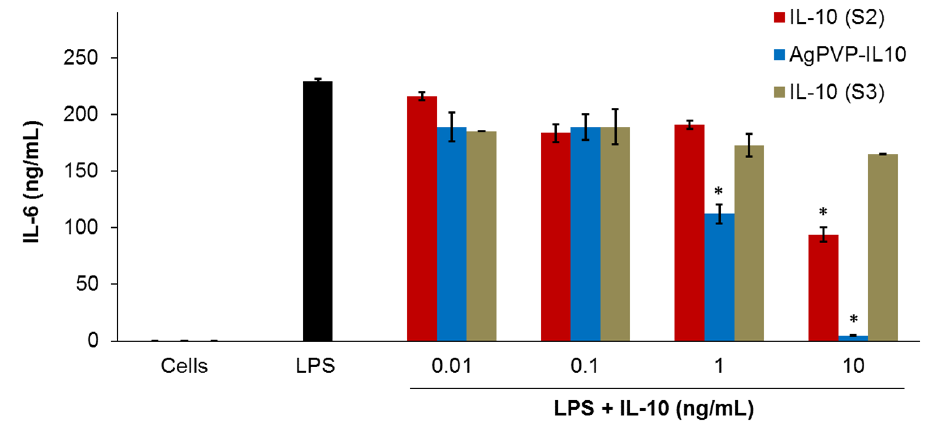
Figure 7. The effect of storage of free rmIL-10 and rmIL-10 conjugated to Ag-PVPs on the production of IL-6 by mouse J774 macrophages stimulated with LPS. Cells (10 6 cells/mL) were stimulated with LPS (1 µ g/mL) and treated with different concentrations of either free rmIL-10 (after one freeze-thaw cycle, S2), free rmIL-10 (stored one week at 4 ◦ C, S3), or rmIL10-conjugated Ag-PVPs (stored one week at 4 ◦ C). Cell-free culture supernatants were collected at 72 h post-incubation and were used to measure the production of IL-6 by cytokine ELISA. Untreated and LPS-stimulated cells were used as positive controls, and untreated and non-stimulated cells were used as negative controls. * indicates a significant difference ( p < 0.01) between the untreated and LPS-stimulated cells versus LPS-stimulated and treated cells as calculated by the unpaired Student’s t -test. The data are presented as means and standard deviations of samples run in duplicate and are representative of two separate experiments.